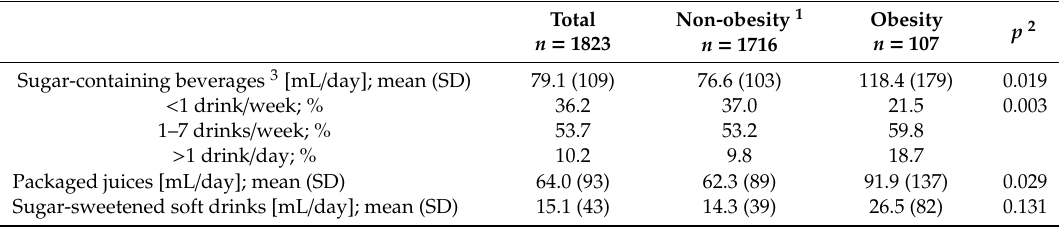
Table 2. Mean daily consumption of sugar-containing beverages in children at 4–5 years in the INMA study according to their obesity status.